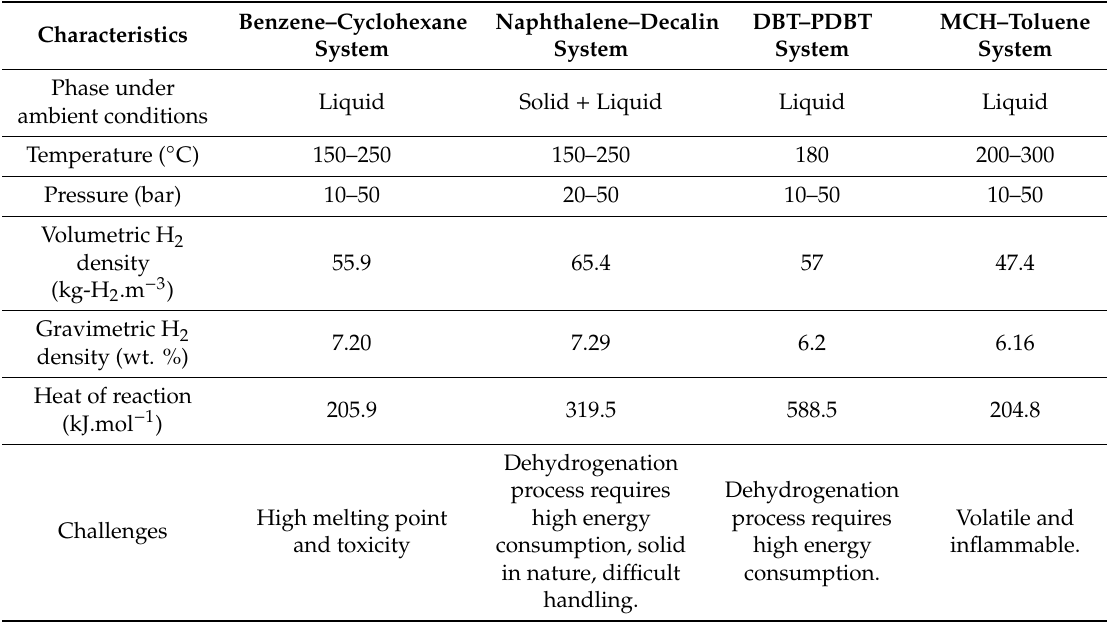
Table 4. Comparison of various liquid organic hydrogen carriers (LOHCs) for hydrogen storage [7–9].